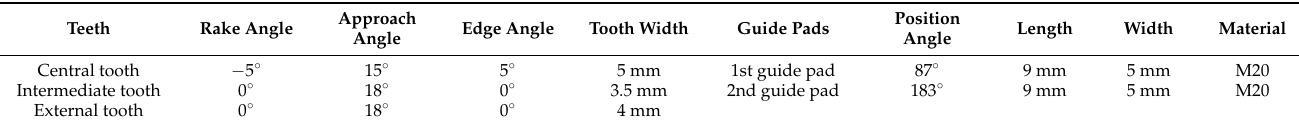
Table 1. Geometric parameters of ∅ 17.75 mm BTA drill.